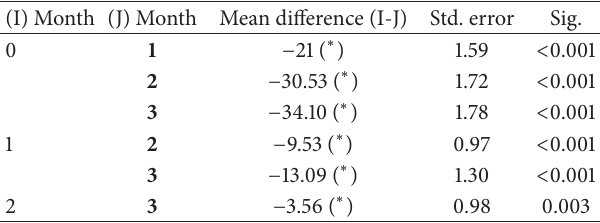
Table 4: Bonferroni post hoc test for pairwise comparisons of changes in self-care before the intervention and during the first, second, and third months after intervention.